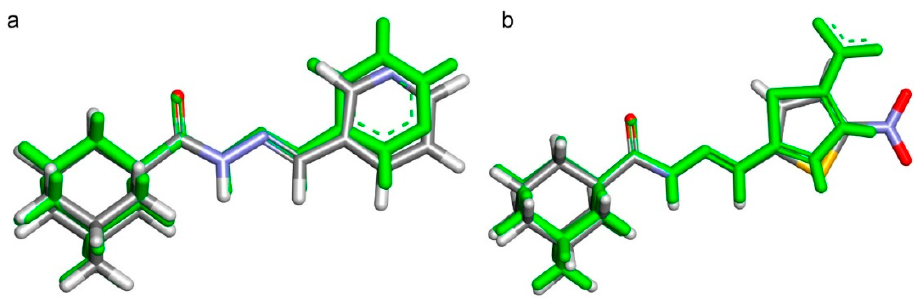
Figure 8. DFT-optimized geometries of 1 ( a ) and 2 ( b ). The corresponding crystal structures are shown superimposed in green. Atom color code: C (grey), H (white), O (red), N (blue), S (yellow).